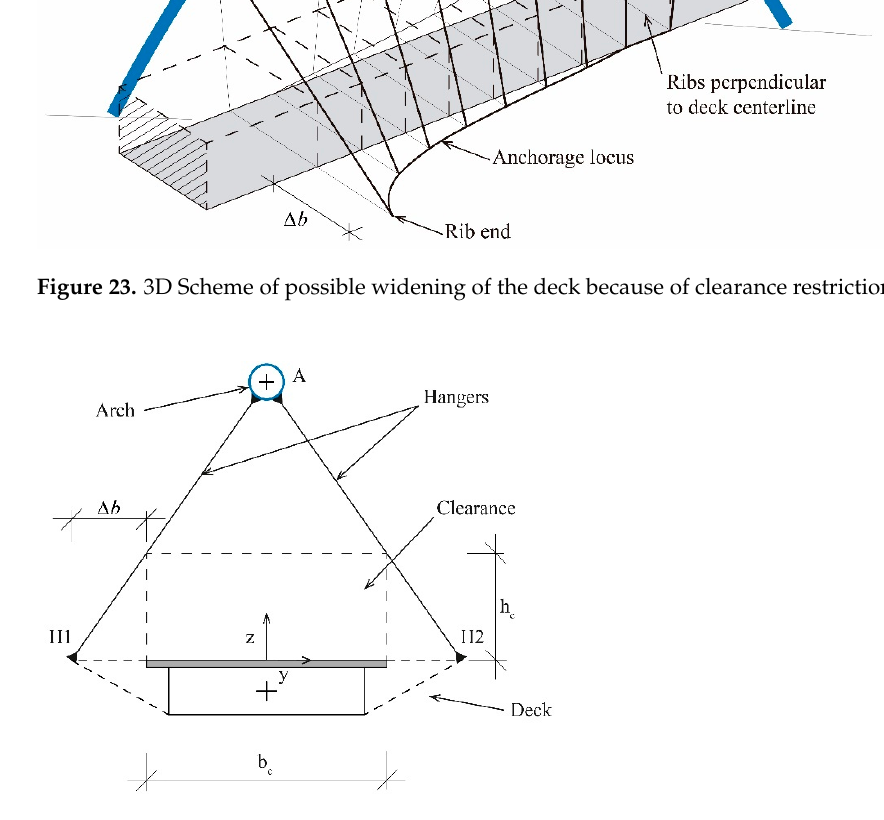
Figure 25. ( a ) Symmetric widening at each edge of the deck, ( b ) asymmetric widening, and ( c ) asymmetric widening with hangers anchored to rigid elements protruding from the deck.